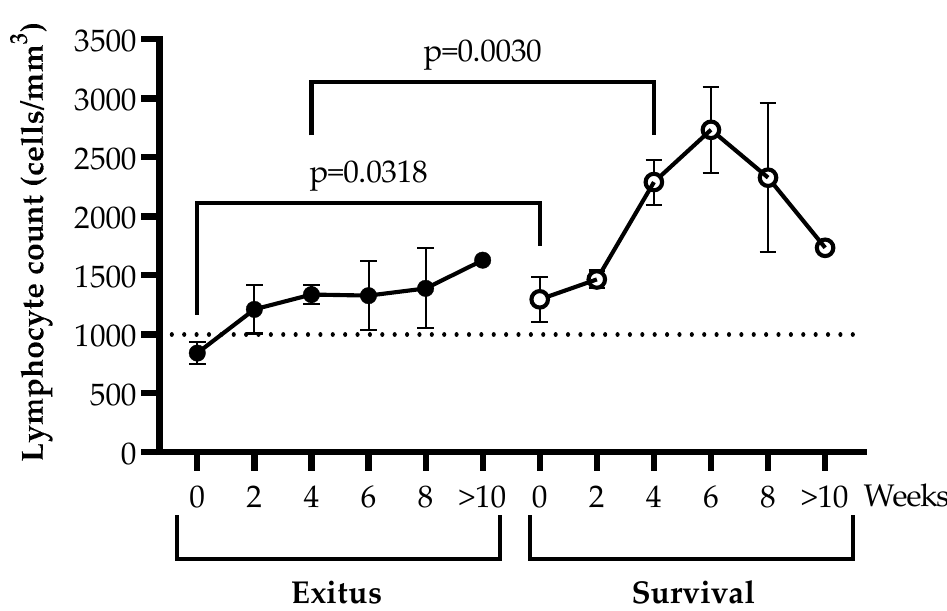
Figure 2. Peripheral blood lymphocyte counts during hospitalization due to critical COVID-19. Lymphocyte count (cells/mm 3 ) was determined every 2 weeks for a total of 13 weeks or until the final outcome in blood samples from the participants of the Exitus (filled dots) and Survival (blank dots) groups. The threshold for lymphopenia is shown at 1000 cells/mm 3 with a dotted line. Each dot corresponds to the mean of data, and vertical lines represent SEM. Statistical significance between groups was calculated using Mann–Whitney U-test, and within groups, Wilcoxon U-test was used.